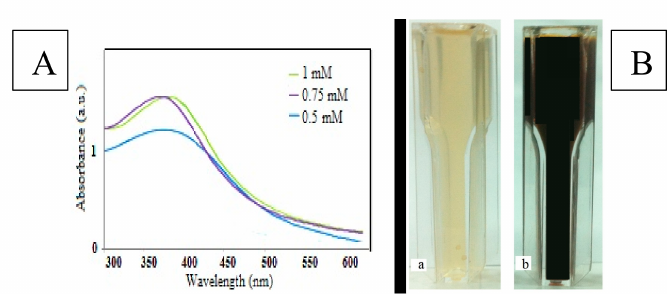
Figure 1. ( A ) UV-visible absorption spectra of R. officinalis extract. ( B ) Photograph of samples change color. ( a ): Rosmarinus officinalis extract; ( b ): iron oxide (Fe 3 O 4 ) nanoparticles